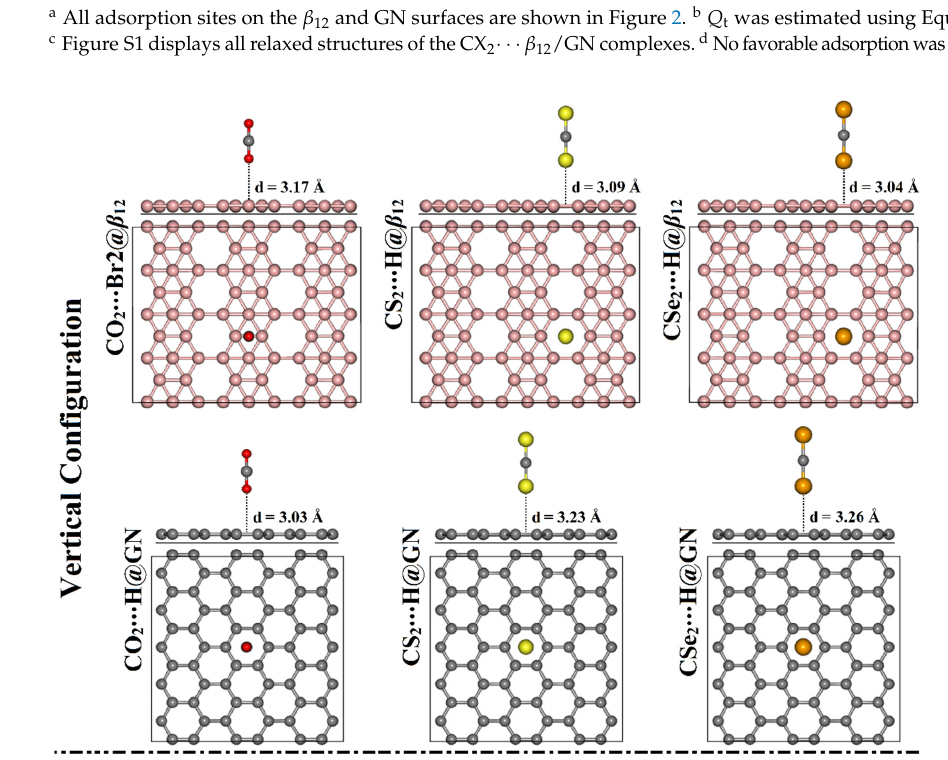
Figure 3. Side and top representations for the relaxed structures of the vertical and parallel config- urations of the CX 2 ∙∙∙ β 12 /GN complexes (where X = O, S, or Se) at the most favorable energetic sites. Equilibrium distances (d) are given in Å. Apparently, the relaxed structures of the CX 2 ∙∙∙ β 12 /GN complexes showed the ability of the β 12 and GN sheets to adsorb toxic CX 2 molecules (Figure S1), resulting in significant